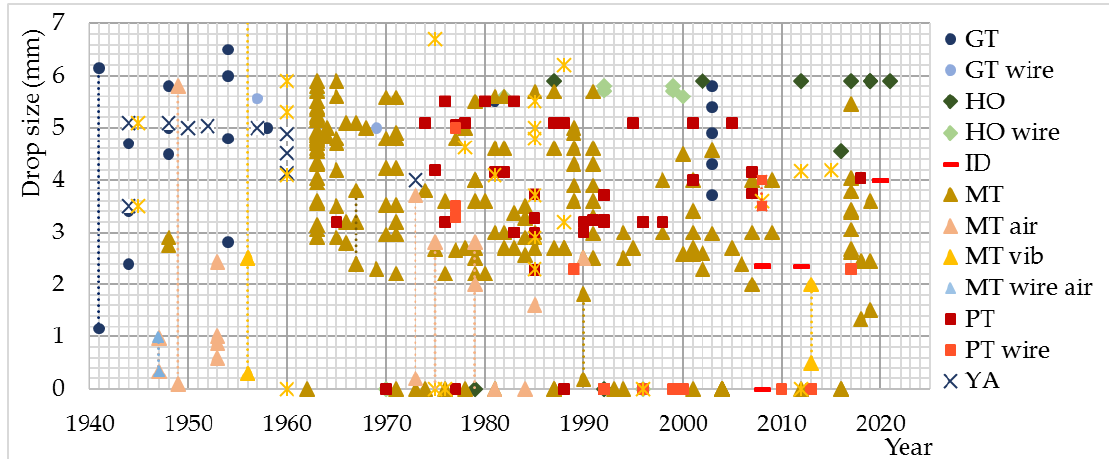
Figure 13. Type and subtype (modified performance drippers) of drippers and corresponding sizes of generated drops applied in previous rainfall simulations (GT—Glass tubes, GT wire—Glas tubes with threads, HO—Holes in dripper reservoir, HO wire—Holes in dripper reservoir with threads, ID—Irrigation drippers, MT—Metal tubes, MT air—Metal tubes under influence of air flow, MT vib—Metal tubes under influence of vibration, MT wire air—Metal tubes with threads under influence of air flow, PT—Plastic tubes, PT wire—Plastic tubes with threads, YA—Hanging yarn and UN— unspecified drippers type). Note: for markers that are on a horizontal line with a value of 0, they are